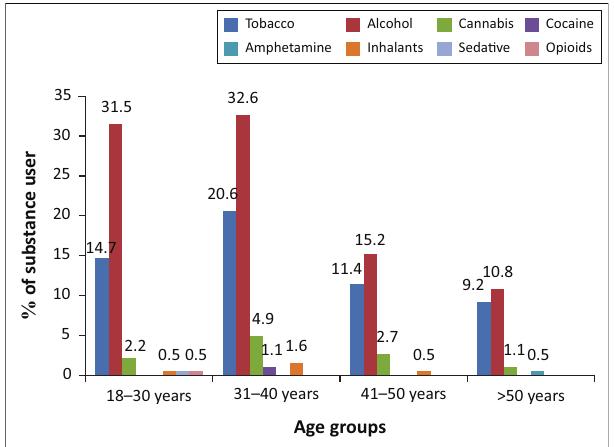
FIGURE 3: Lifetime use of substances amongst people living with human immunodeficiency virus in Mthatha, South Africa ( n = TABLE 2: Alcohol, Smoking and Substance Involvement Screening Test risk score of current substance use amongst people living with human immunodeficiency virus in Mthatha, South Africa. Variables